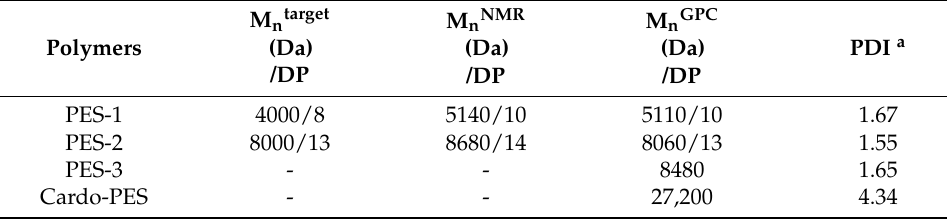
Table 1. Composition and physical properties of the